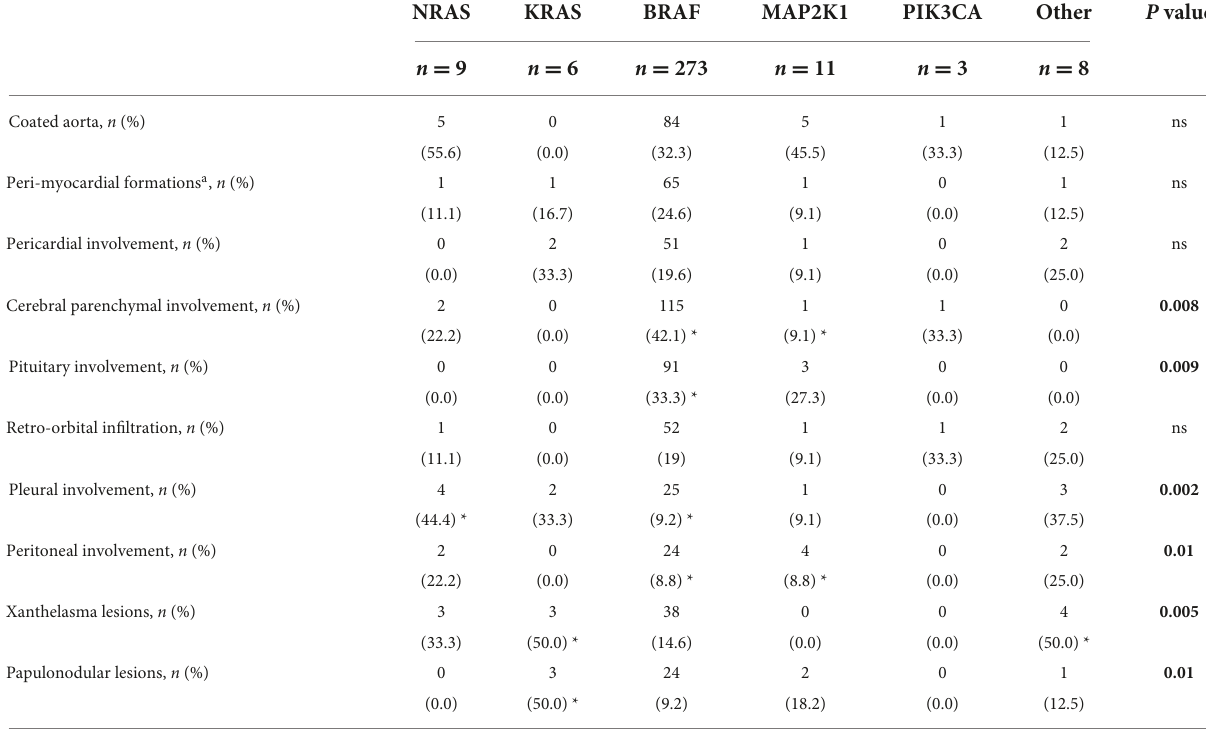
TABLE 3 Specific cardiac and non-cardiac involvements of Erdheim–Chester patients according to different